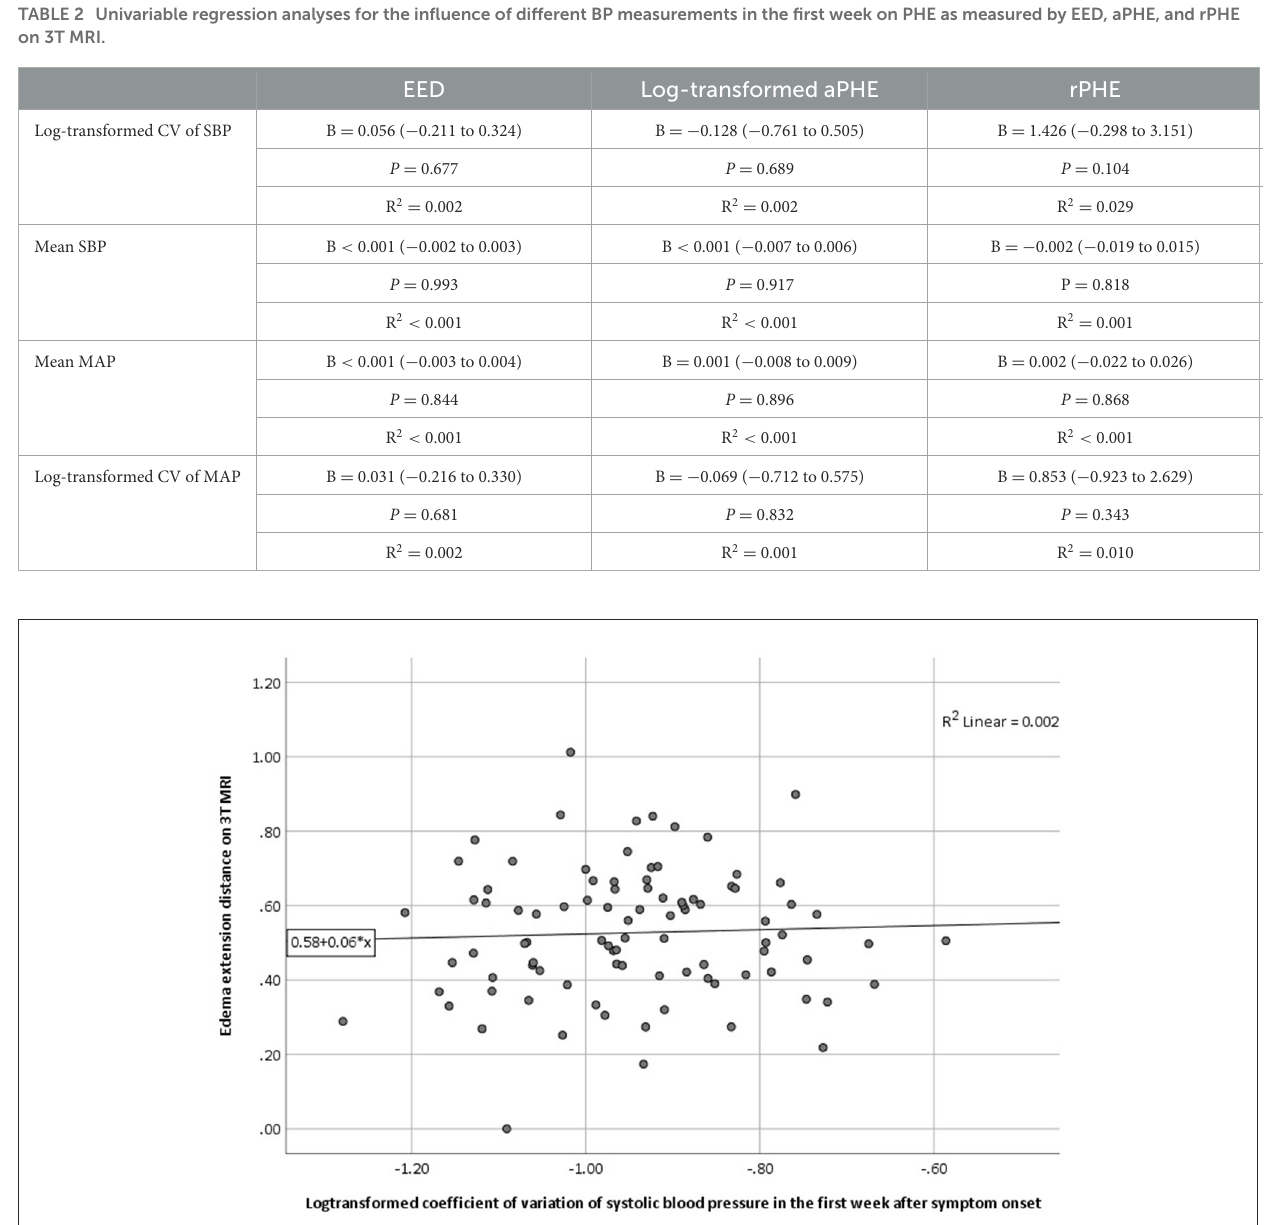
FIGURE1 Association between (log-transformed) CV of SBP in the first week and the presence of PHE as measured by EED on 3T MRI (univariable regression analysis). 3T MRI, 3 tesla magnetic resonance imaging; CV, coefficient of variation; EED, edema extension distance; PHE, perihematomal edema; SBP, systolic blood